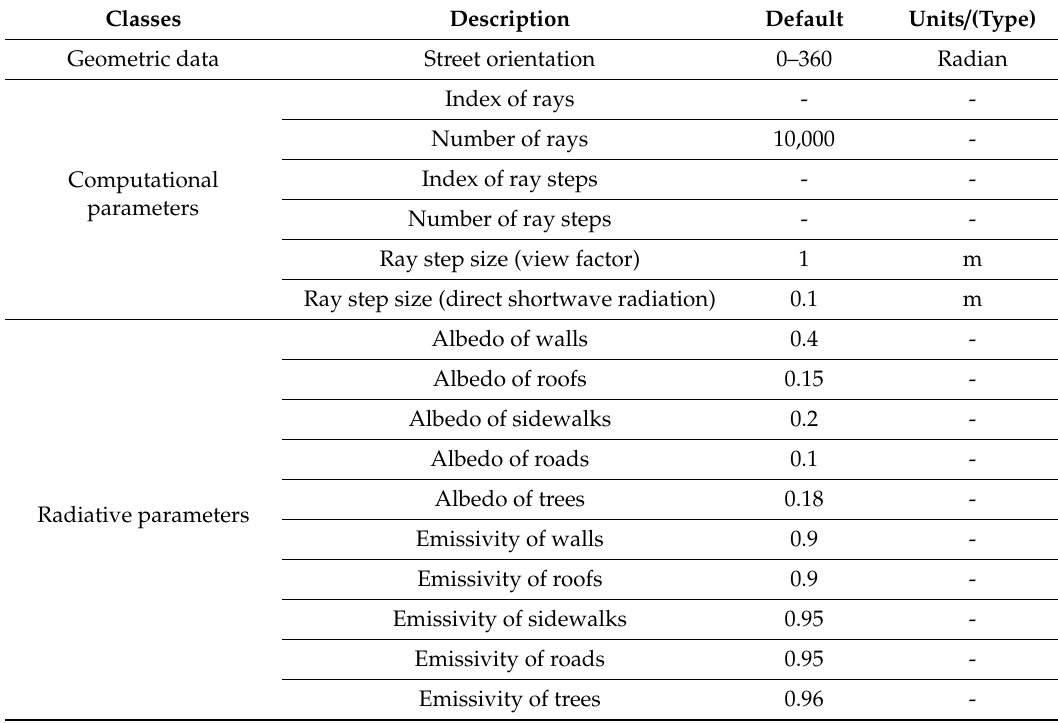
Table A1. Model parameters of the multi-layer mean radiant temperature (MMRT)